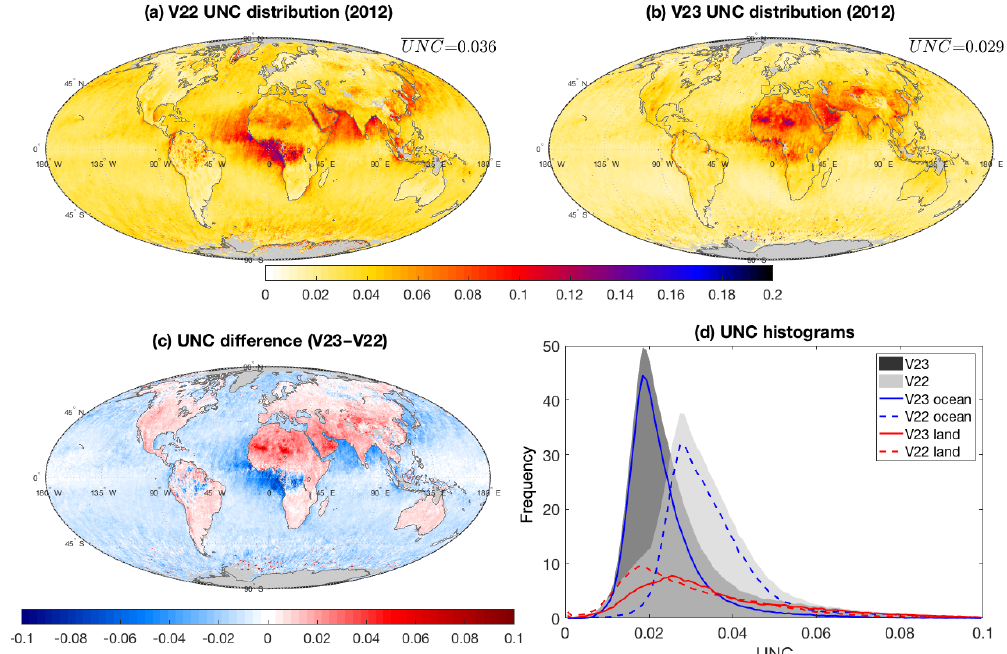
Figure 8. As in Fig. 7 but instead using the MISR-reported pixel-level AOD uncertainties (UNC). Because of the uncertainties related to extrapolating V22 UNC values from MISR 558nm band to 550nm band, the values from V22 are analyzed at the 558nm wavelength.